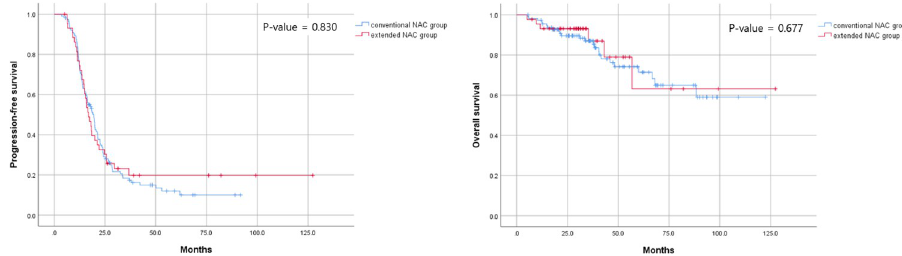
Fig 1. Kaplan-Meier curve for survival between the conventional and extended NAC groups. (A) progression-free survival and (B) overall survival. NAC, neoadjuvant chemotherapy.